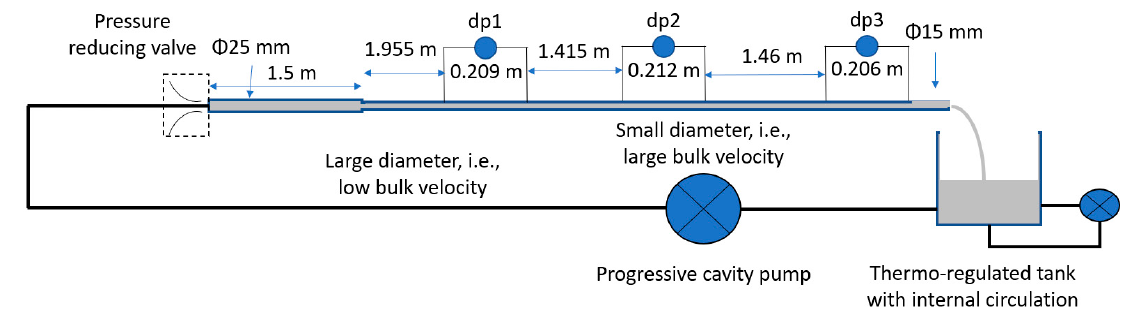
Figure 8. Schematic description of the laboratory flow-loop.